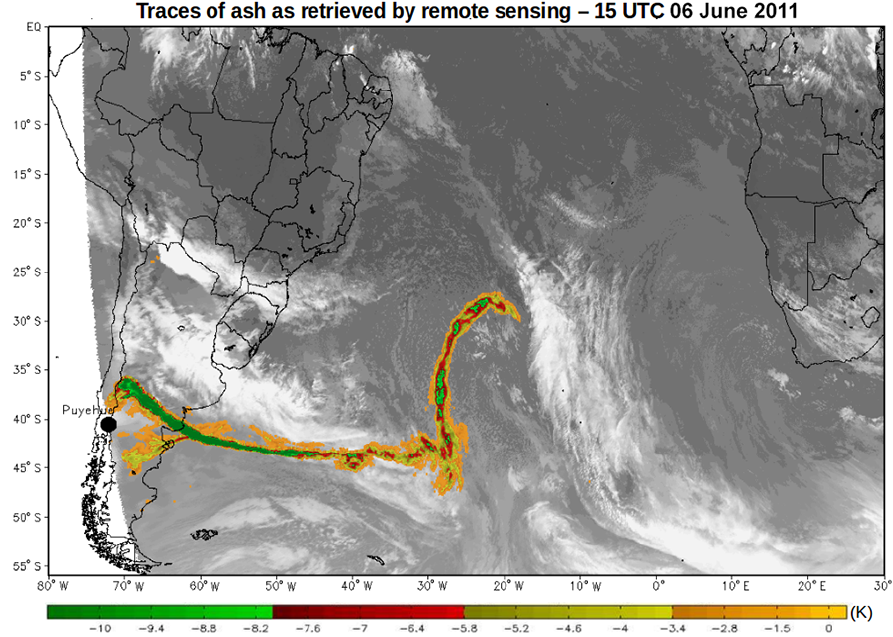
Figure 16. Traces of volcanic ash associated with the eruption of the Puyehue volcano as retrieved from METEOSAT-8 satellite data. The image corresponds to 6 June 2011 at 15:00UTC. The color scale refers to the temperature difference between the infrared 10 and 11 channels (Costa et al., 1012), the contrast allowing one to identify the